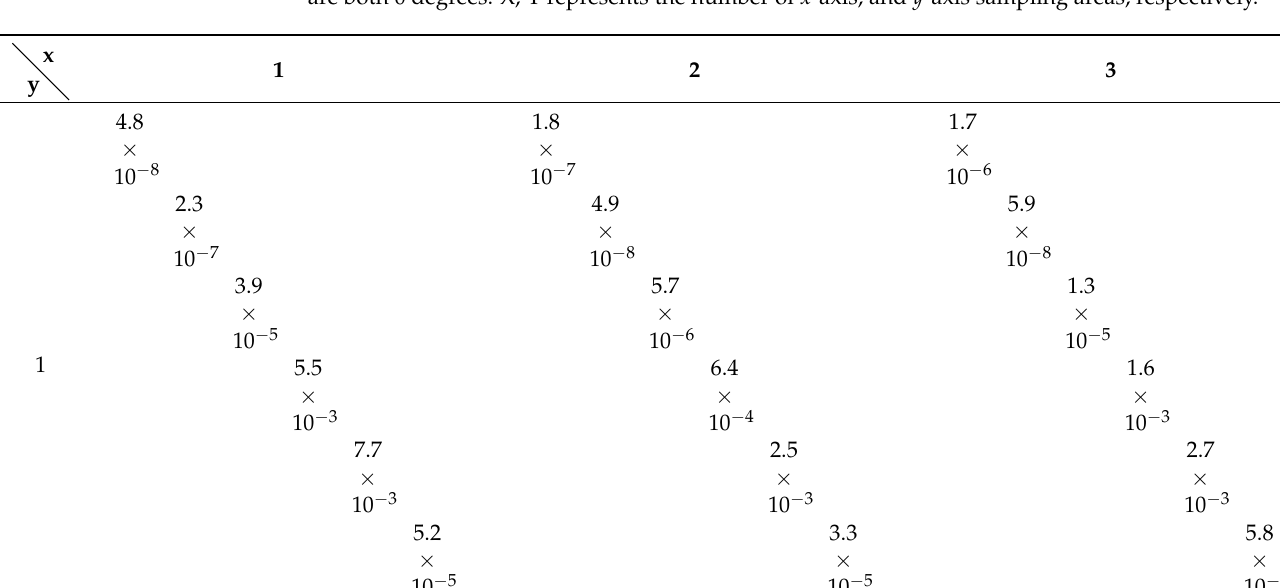
Figure 8. The detection of ARCUO in two experiments. Table 1. The covariance in each sampling area of the first quadrant when roll and pitch angle of